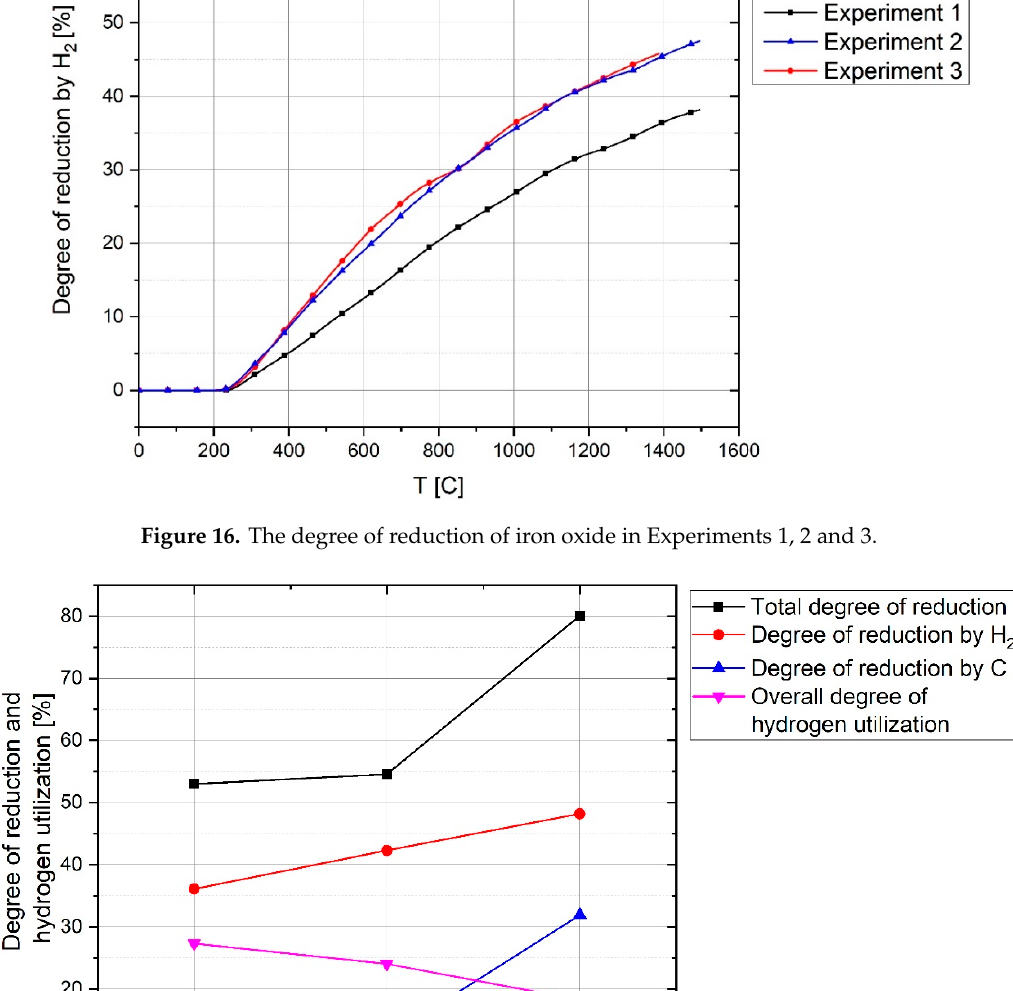
Table 8. Element content (wt.%) of reduced iron, Experiment 1.